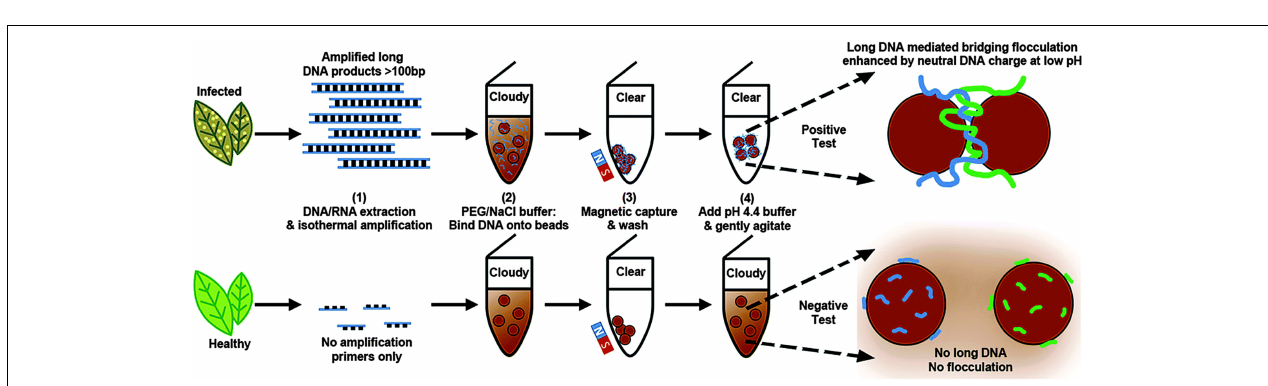
FIGURE 1 | Schematic representation of the electrochemical bioassay for plant pathogen diagnosis involving incubation of the amplified target, AuNPs-DNA probes and streptavidin beads (reproduced with permission from Lau et al., 2017).